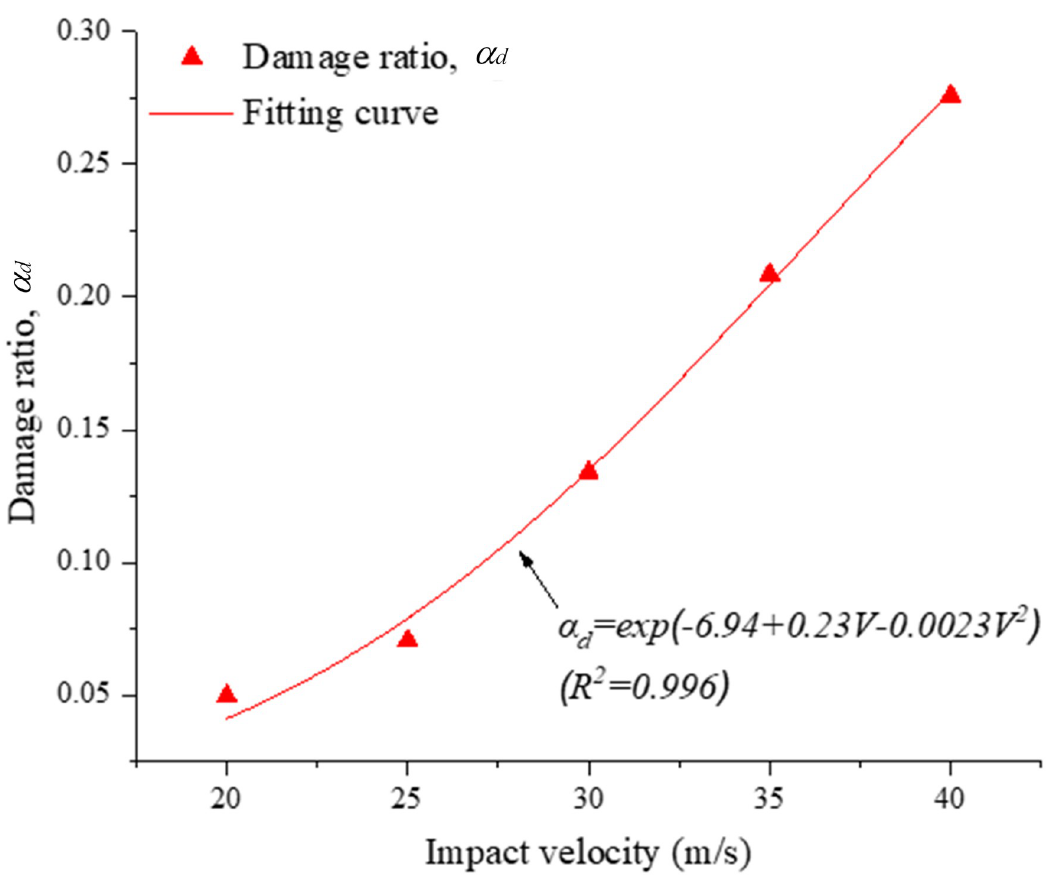
Fig 16. Variation in damage ratio ( α d ) with the impact velocity.